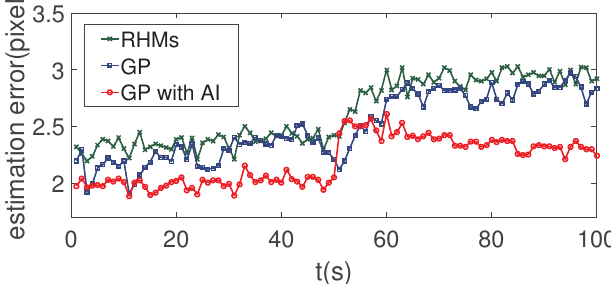
Figure 5. Comparison of tracking precision between RHMs, GP and the proposed GP with AI.